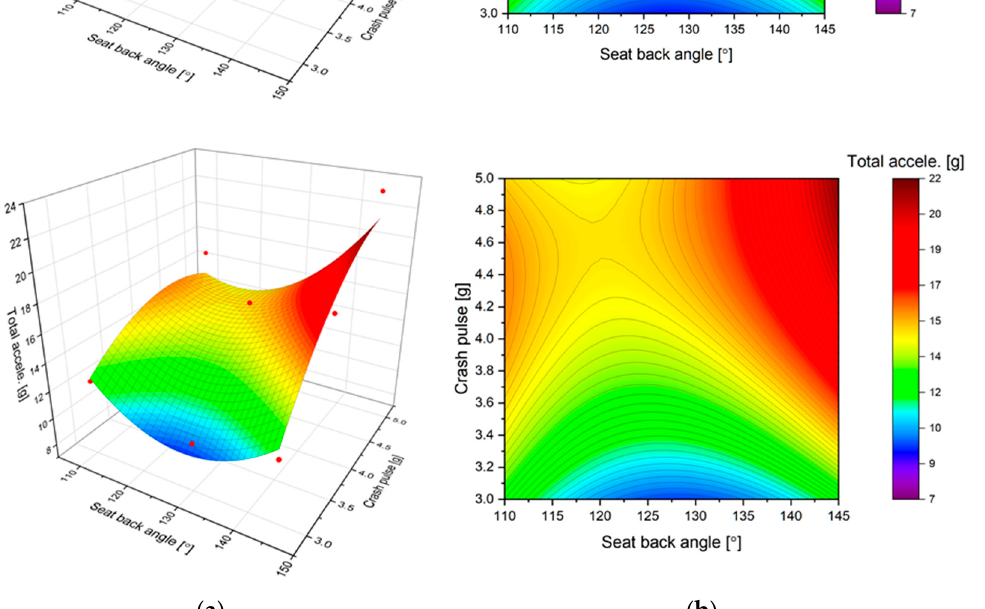
Figure 8. Predicted (estimated) response for acceleration of the dummy’s head: ( a ) fitted response surface; ( b ) fitted response profile.